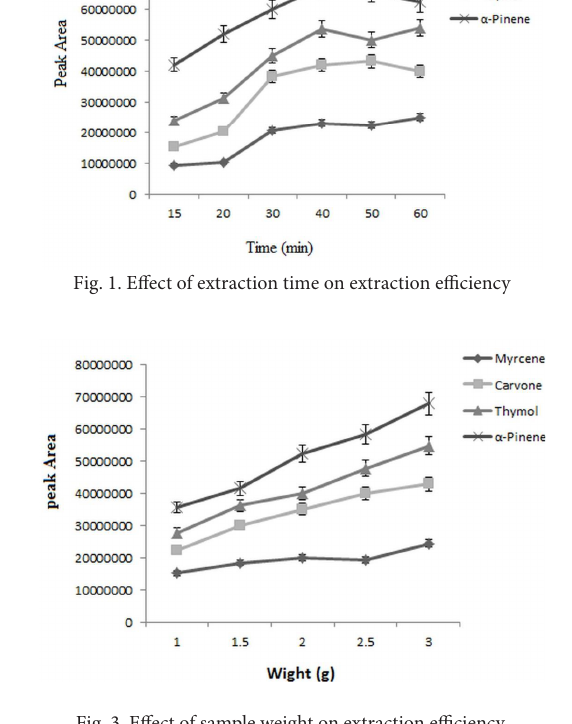
Fig. 3. Effect of sample weight on extraction efficiency.